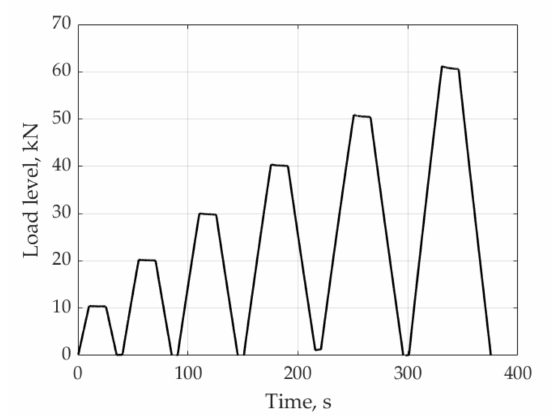
Figure 2. Scheme of sample loading.